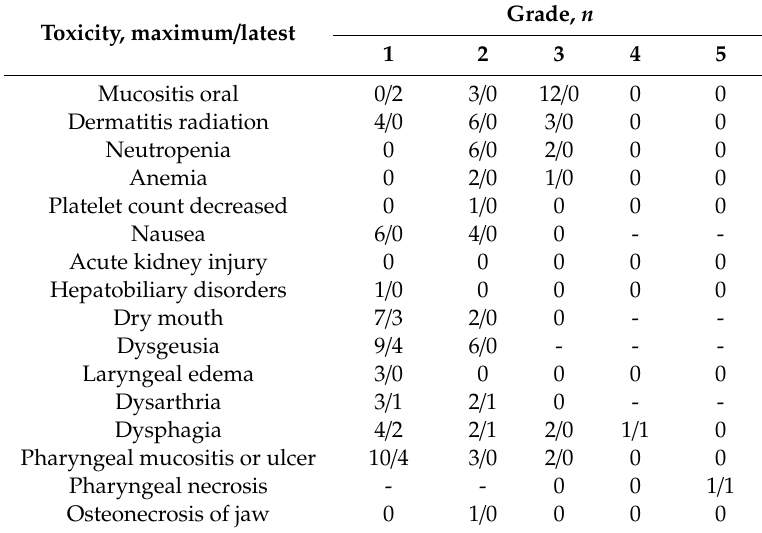
Figure 3. MRI of a patient, cT4aN0M1 (lung), before and after treatment. The tumor showed a CR but necrotic ulcer occurred. It was healed with conservative treatment. ( A ) Before treatment. White arrow: tumor. ( B ) The dose distribution of PBT. ( C ) After 2 months. Red circle: necrotic ulcer. Table 4. Adverse events (NCI-CTCAE v. 4.0).